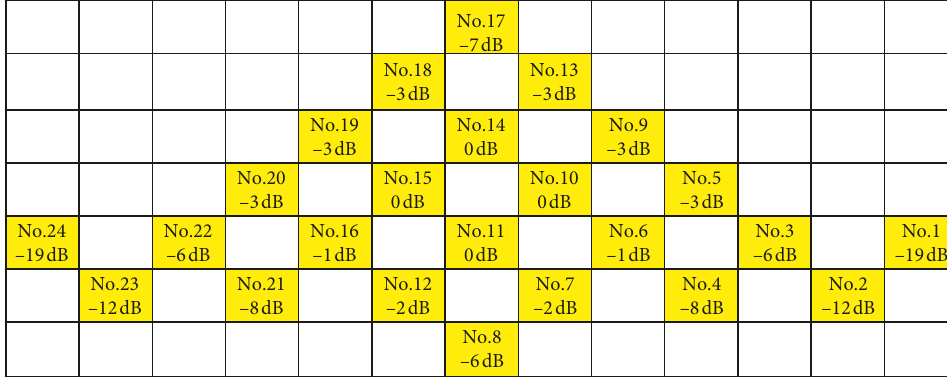
Figure 3: Diamond-shaped aperture with adaptive nulling tapering in Mode II. Table 1: Comparison of diamond-shaped and rectangular